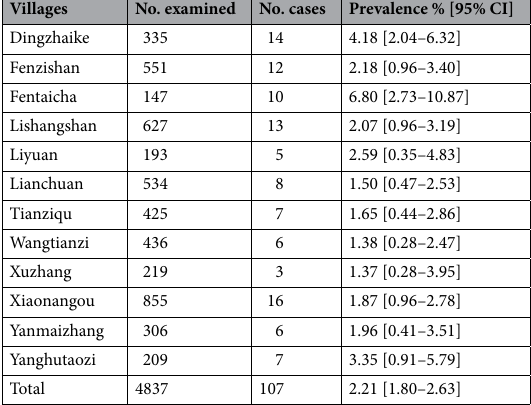
Table 1. Prevalence of cystic echinococcosis in 12 villages of Xiaonangou Township in 2011. CI: confidence interval.